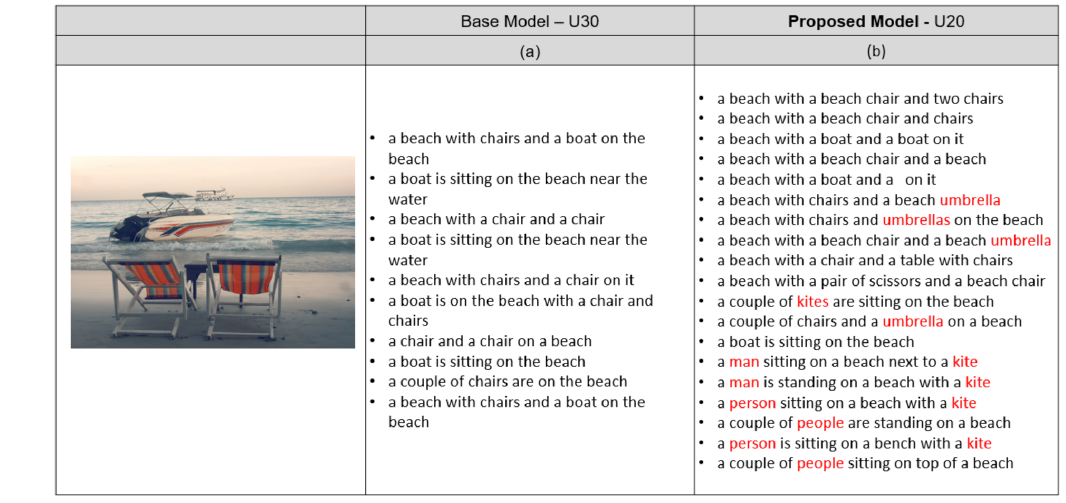
Figure 6. Failure cases of the proposed model that generate image-independent